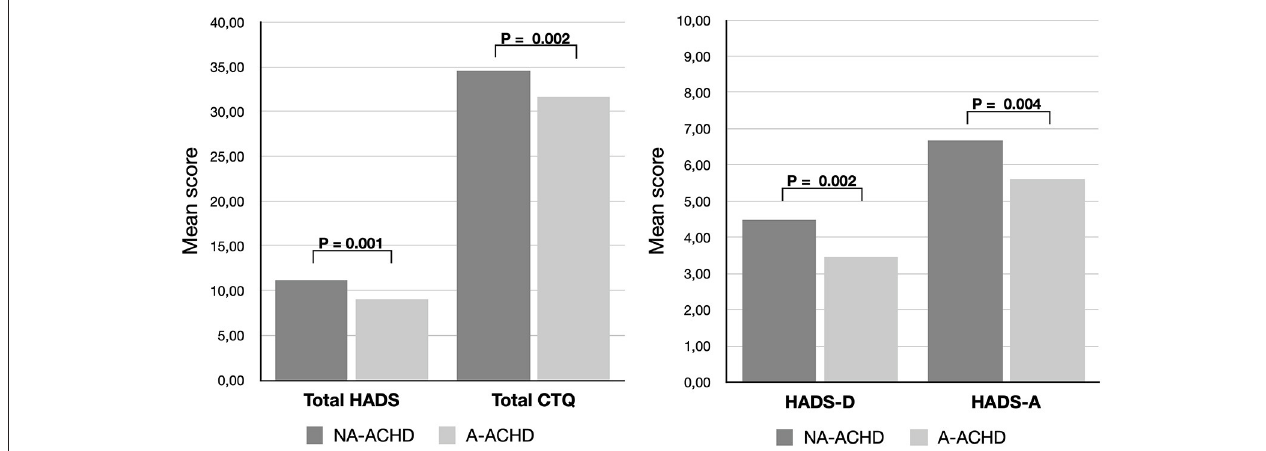
FIGURE 3 | Comparison of the mean score of the hospital anxiety and depression scale (total HADS score) and its sub-scores for depression (HADS-D) and anxiety (HADS-A) as well as the childhood trauma questionnaire (CTQ), showing significantly higher levels in non-adherent patients (NA-ACHD) compared to adherent patients (A-ACHD).